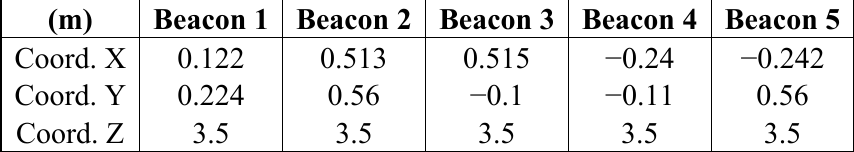
Table 4. Position of beacons in the GEINTRA LPS after a manual